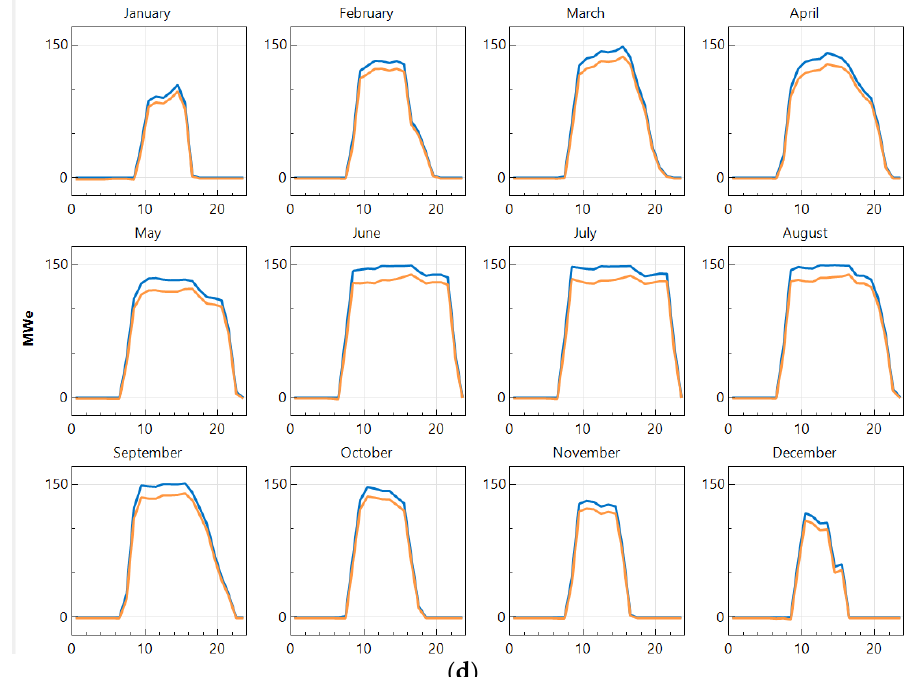
Figure 11. Solana power plant in Ma’an with SAM monthly average daily operation over a year. X is the time of the day, in typical days for every month. Y is the field thermal power absorbed ( a ), the thermal energy into storage (negative is out of storage) ( b ), the cycle thermal power input ( c ), and the power gross and net at the turbines ( d ). Note: orange lines refer to gross while the blue ones refer to the net.